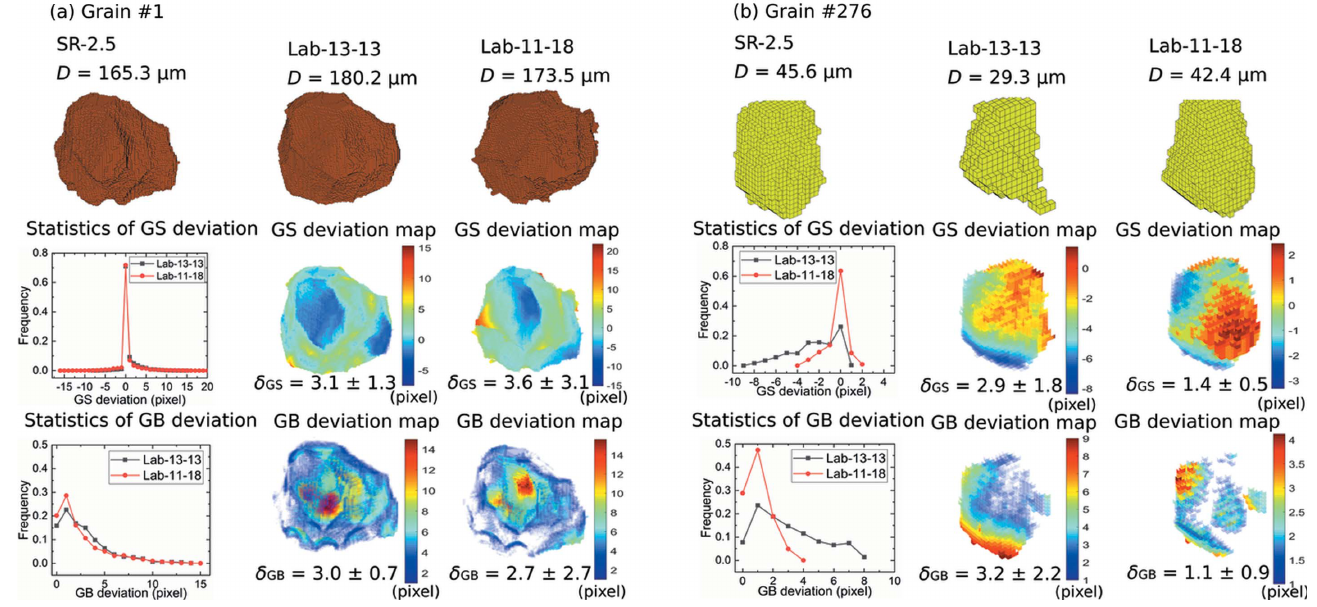
Figure 5 Comparison of GSs and GB positions between the two LabDCT datasets and SR-2.5 for ( a ) grain #1 and ( b ) grain #276. 3D voxelized volumes are shown in the top row. GS deviation statistics and maps are shown in the middle row and GB deviations are shown in the bottom row. The values of (cid:2) GS and (cid:2) GB are given for each deviation map. The grain size (denoted as D ) is given for each